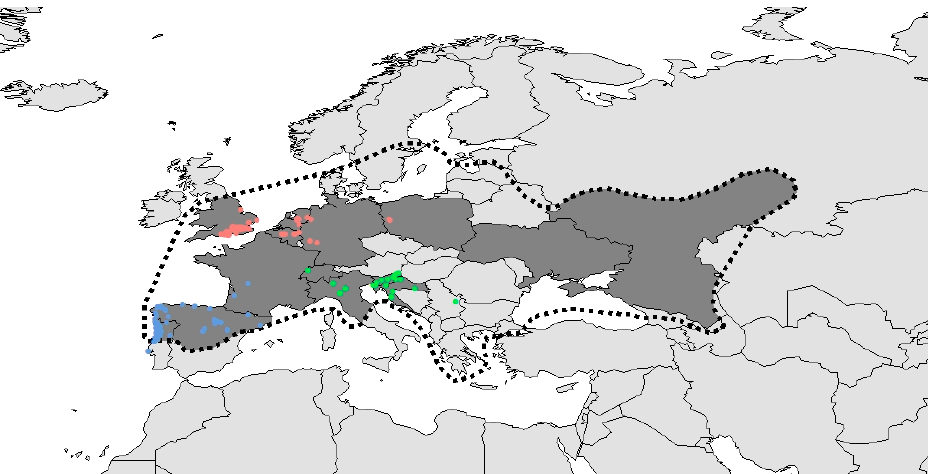
Figure 2. Range (dashed line) of Lucanus cervus and monitoring transects (dots). Countries in dark grey are represented in the European stag beetle monitoring network. Different colours of transects represent different regions (see legend Figure 3).